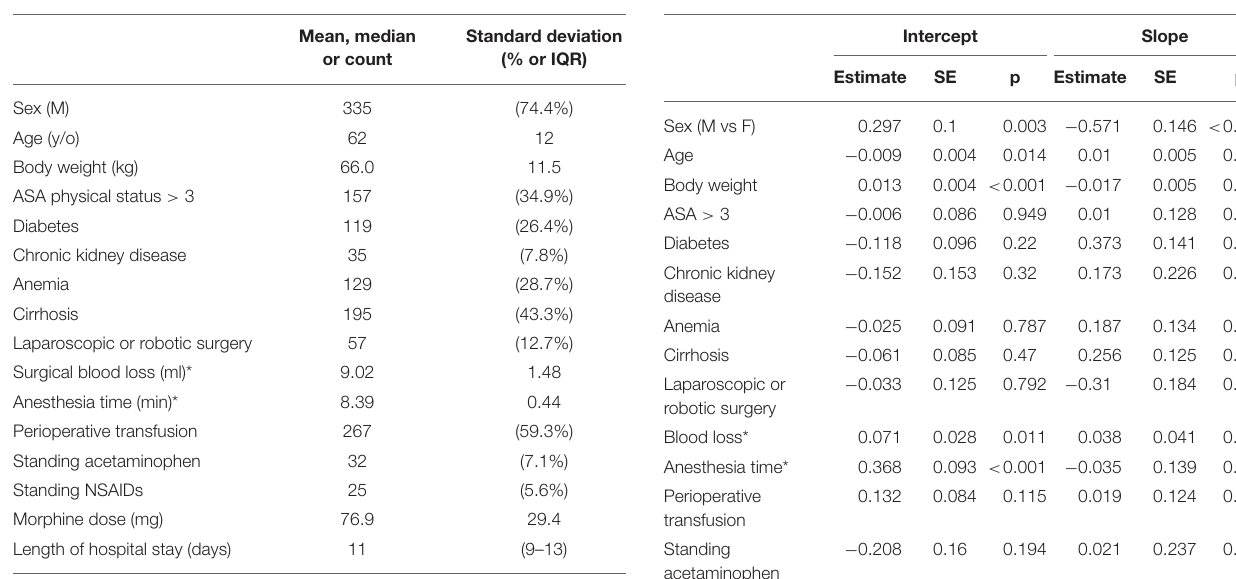
TABLE 2 | Univariate analysis.